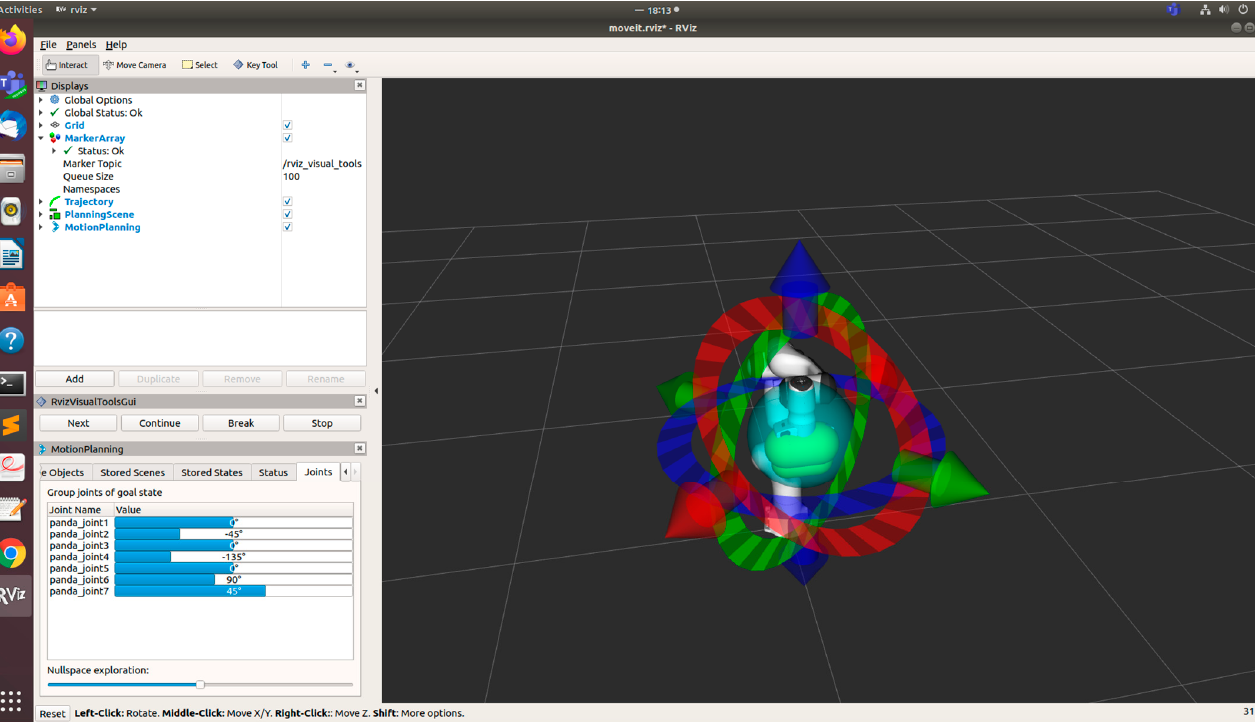
Figure 5. Screenshot of current joint states displayed in RVIZ control panel.